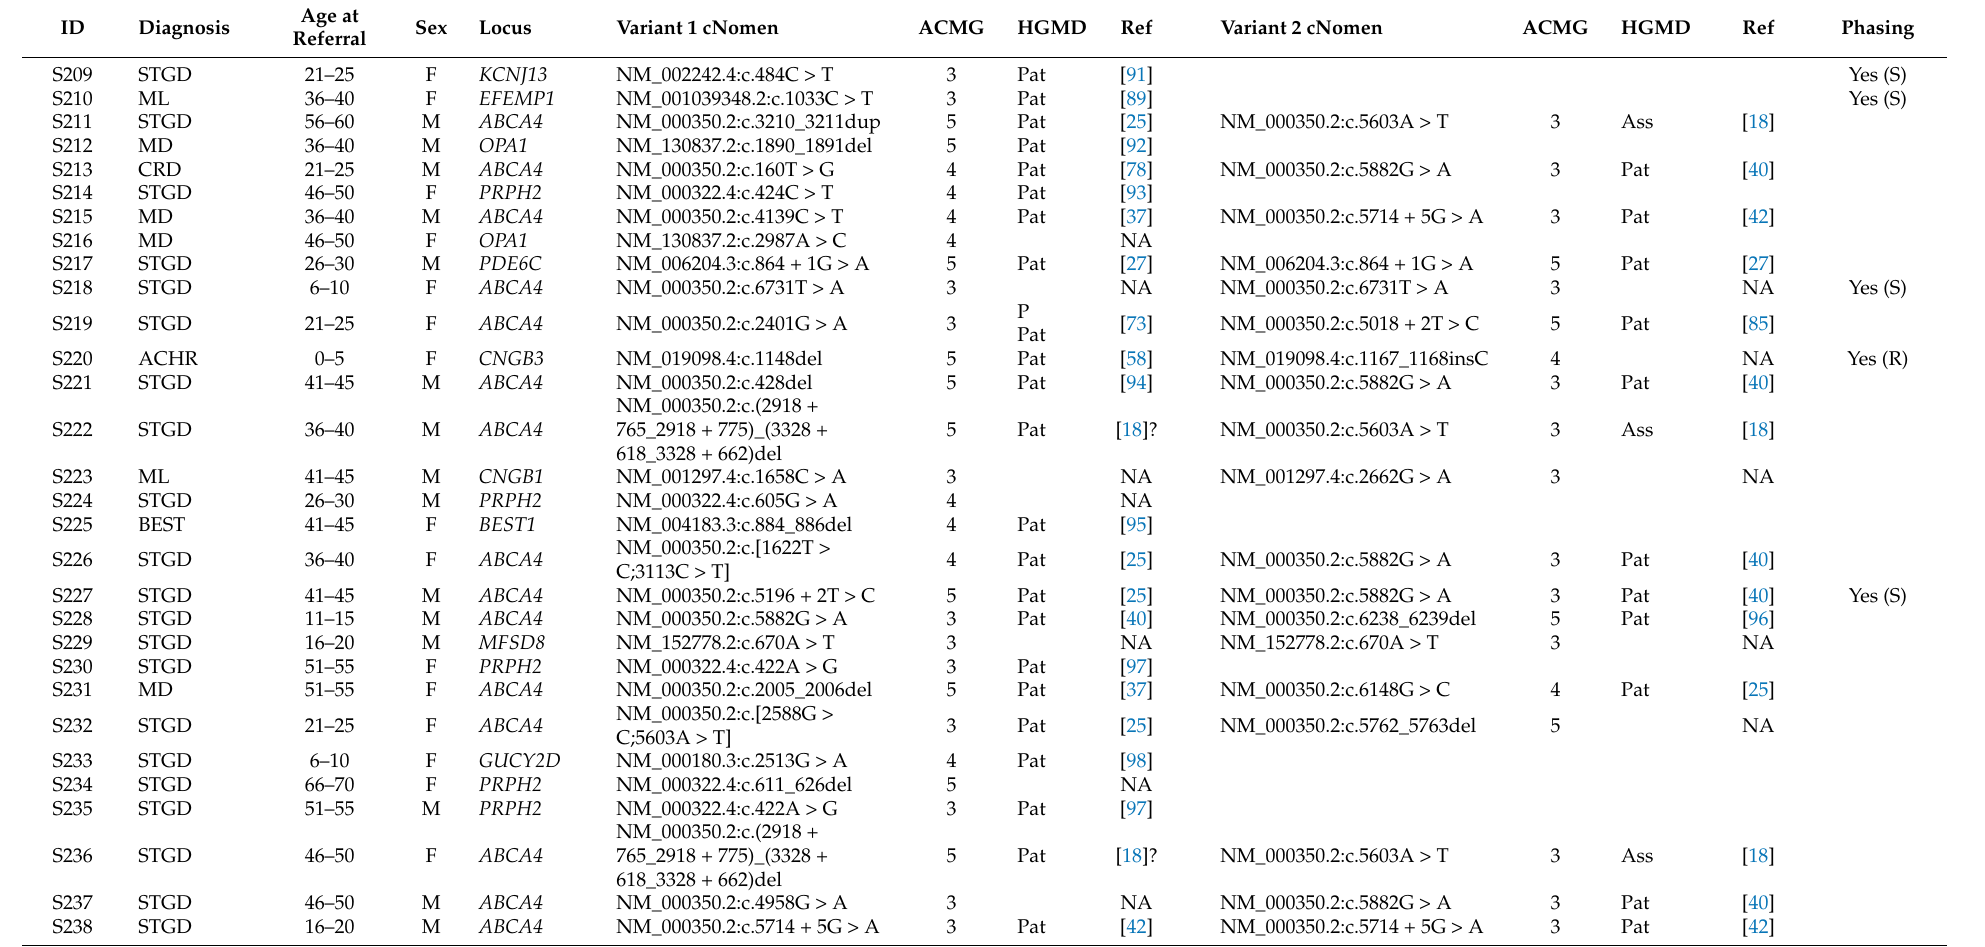
Table A2. No previous testing cohort findings. Abbreviations: ID, index patient ID; cNomen, Human Genome Variation Society (HGVS) cDNA-level nucleotide change nomenclature; HGMD, Human Gene Mutation Database; ACMG, American College of Medical Genetics and Genomics guidelines; F, female; M, male; Pat, pathogenic; P Pat, possibly pathogenic; Ass, association; Ref, reference; NA, not applicable; S, segregation; R, read